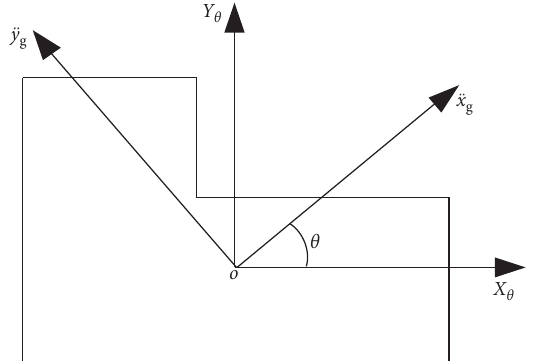
Figure 3: The input angle of a plan-asymmetric